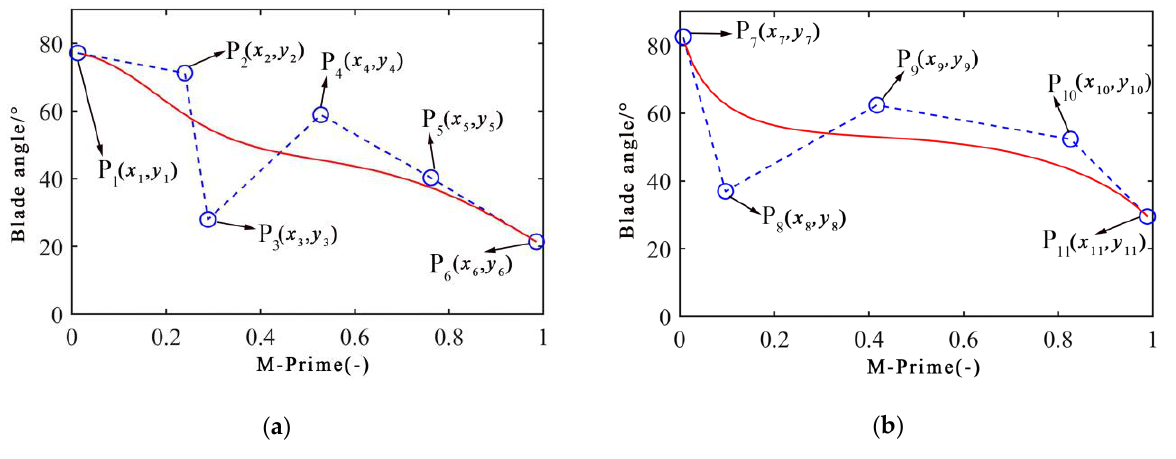
Table 3. Design variables and the variation range of the impeller and guide vane.